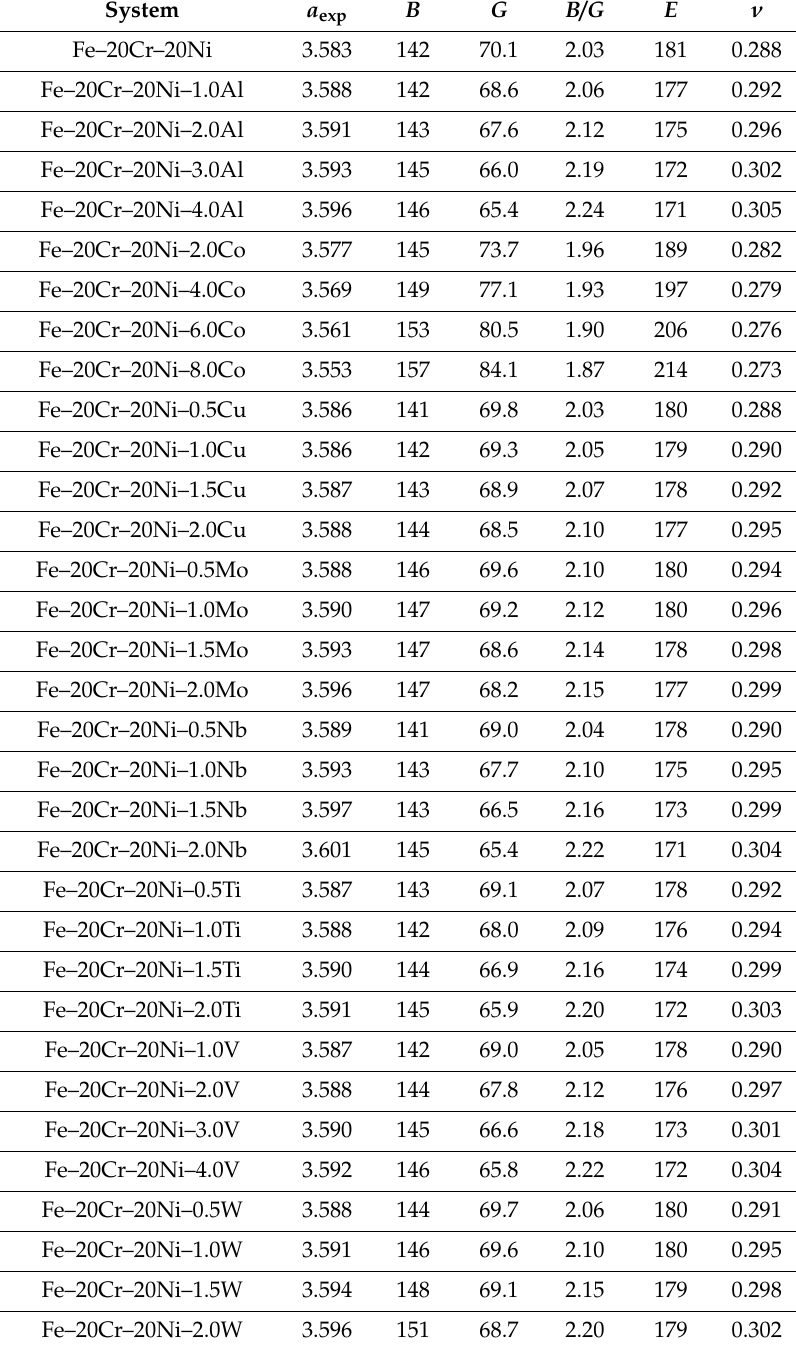
Figure 3 represents the theoretical changes in single-crystal elastic constants (i.e., ∆ C ij ( x ) = C ij (Fe 0.6 − x Cr 0.2 Ni 0.2 M x ) − C ij (Fe 0.6 Cr 0.2 Ni 0.2 )) of paramagnetic fcc Fe 0.6 − x Cr 0.2 Ni 0.2 M x (M = Al, Co,